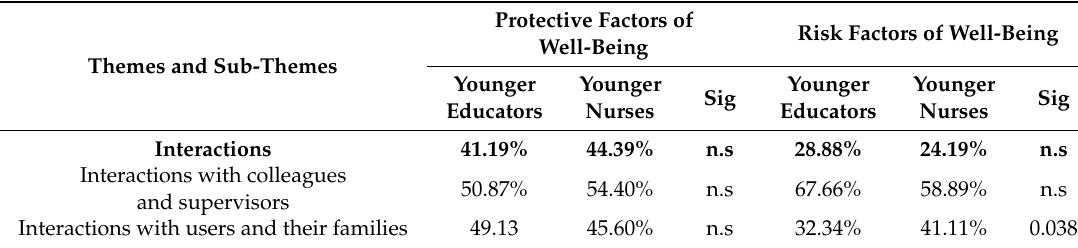
Table 3. Risk and protective factors of well-being at work: data comparison between younger educators and younger